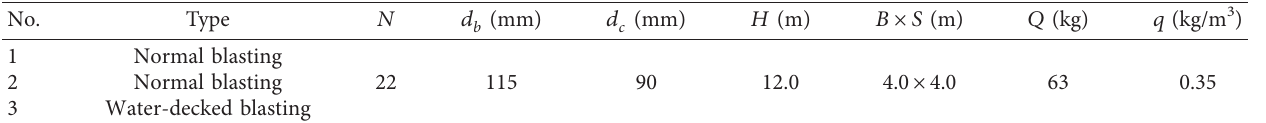
Table 5: Main parameters of blasting tests.